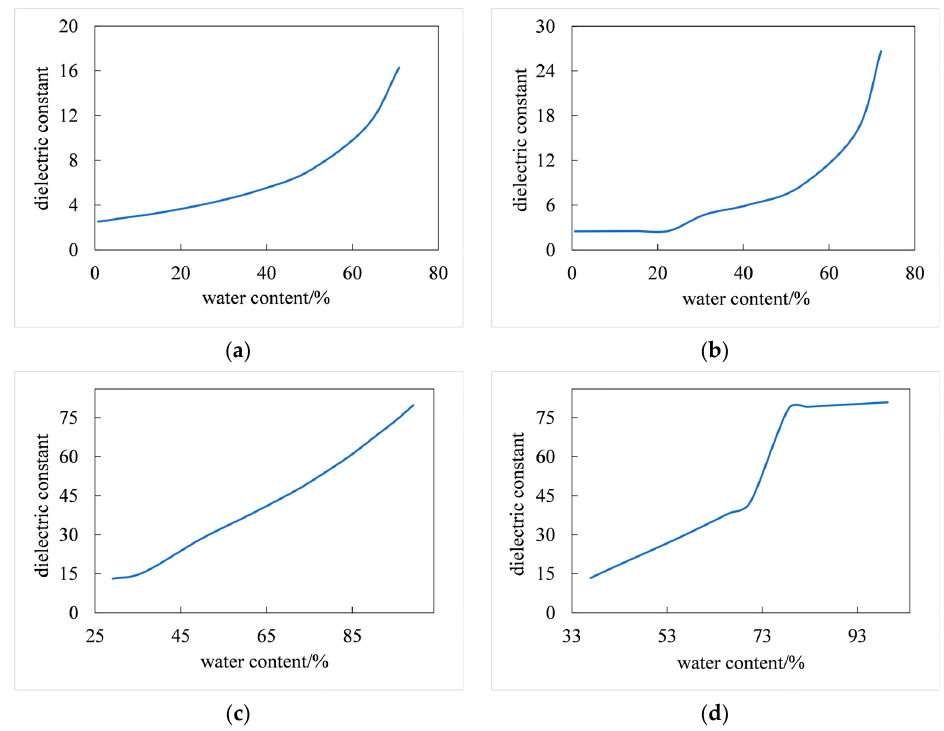
Figure 5. Relationships between water content and dielectric constant in different states. The states are ( a ) O-W, ( b ) O-W, ( c ) W-O, and ( d ) W-O-W.